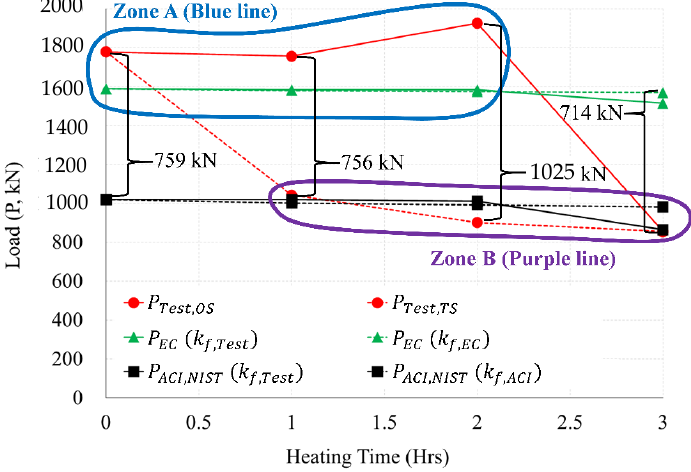
Figure 22. Comparison of load results by test (OS, TS) and Standard (EN1992-1-2, ACI 216.1M-14 and NIST 1681).